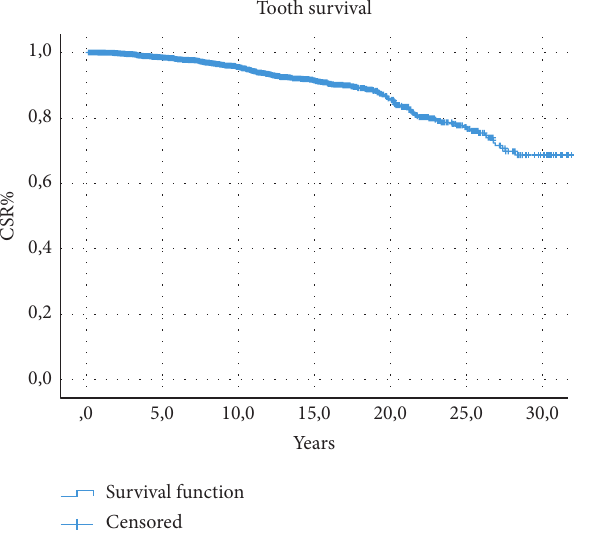
Figure 2: Survival function for all teeth